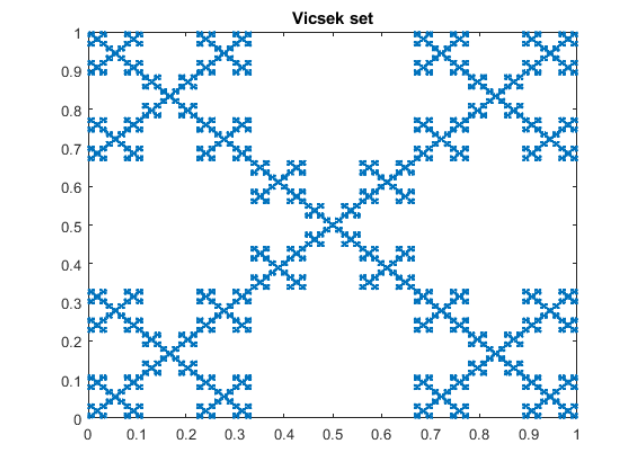
Figure 1: Vicsek set.